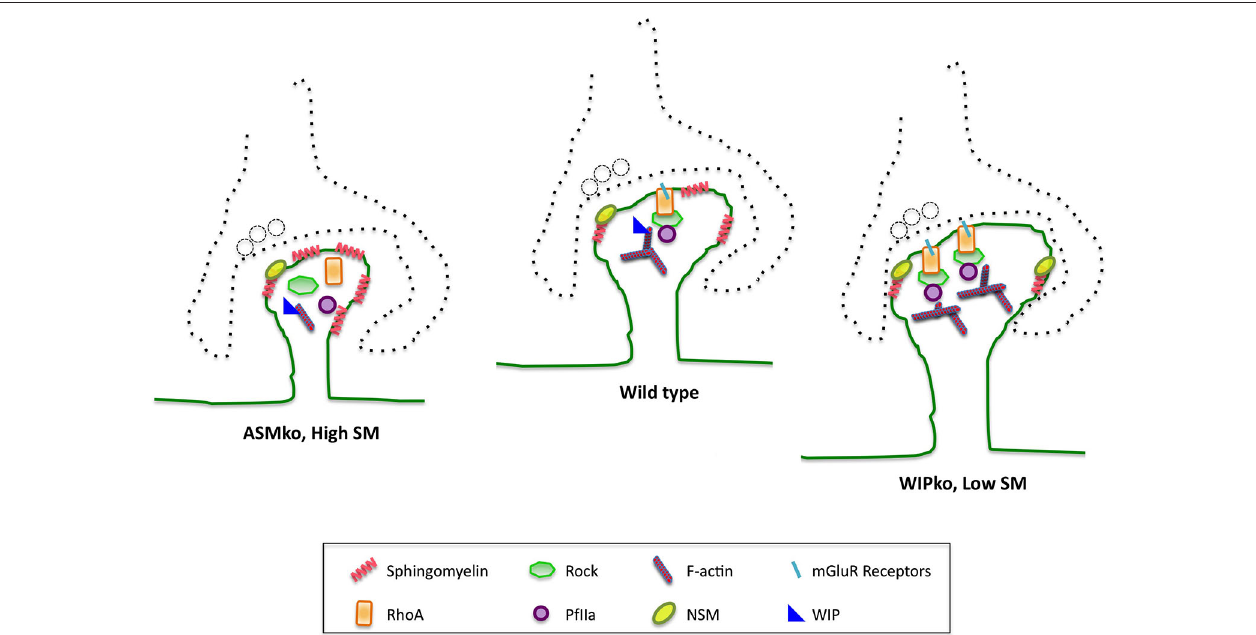
binding and pathway activation, which diminish spine F-actin content and size. These anomalies can be corrected by NSM activation. Conversely, mice lacking the actin related protein WIP show constitutively active NSM leading to reduced SM levels, which enhance RhoA membrane binding and pathway activation resulting in bigger dendritic spines with higher F-actin content. Spine anomalies could explain the cognitive deficits observed in ASMko mice, which are a model for Niemann Pick disease type A, and those of individuals carrying mutations in the region encoding for